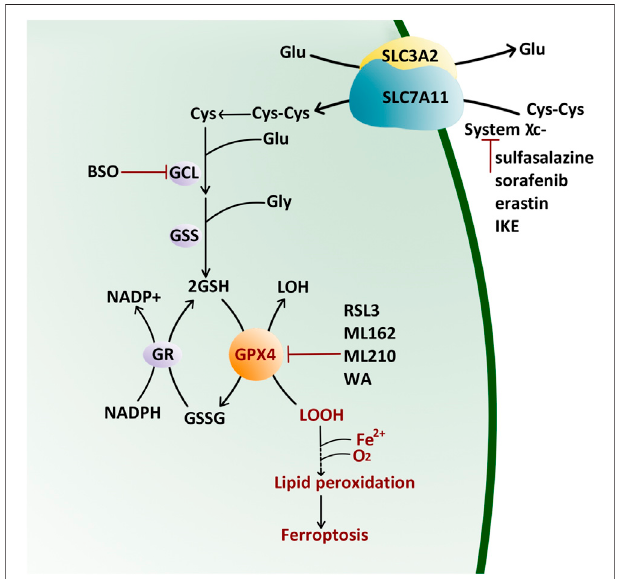
FIGURE 1 | Antioxidant Reaction of GPX4 by the Ping-Pong Pattern. GPX4reduceslipid hydroxide (LOOH) toalcohol (LOH) and then supplements its active site residues through glutathione (GSH) which is synthesized from cystine (Cys-Cys) pumped by the (system χ C − ). Glu: glutamate; Gly: glycine; GCL: glutamate – cysteine ligase; GSS: glutathione synthetase; BSO: L -buthionine sulfoximine; GR: glutathione reductase; NADP: nicotinamide adenine dinucleotide phosphate; GSSG: oxidized glutathione; IKE: imidazole ketone erastin; RSL3: Ras-selective lethal small molecule three; WA: withaferin A.